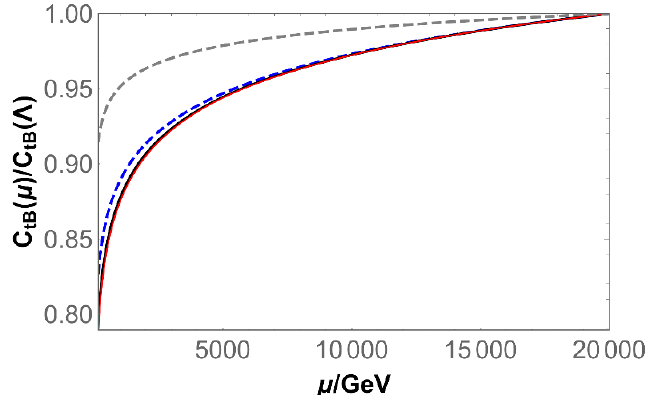
in the ADM (grey t